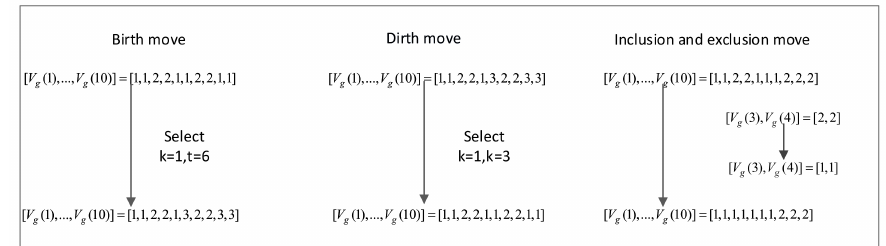
Figure 3. Component transition